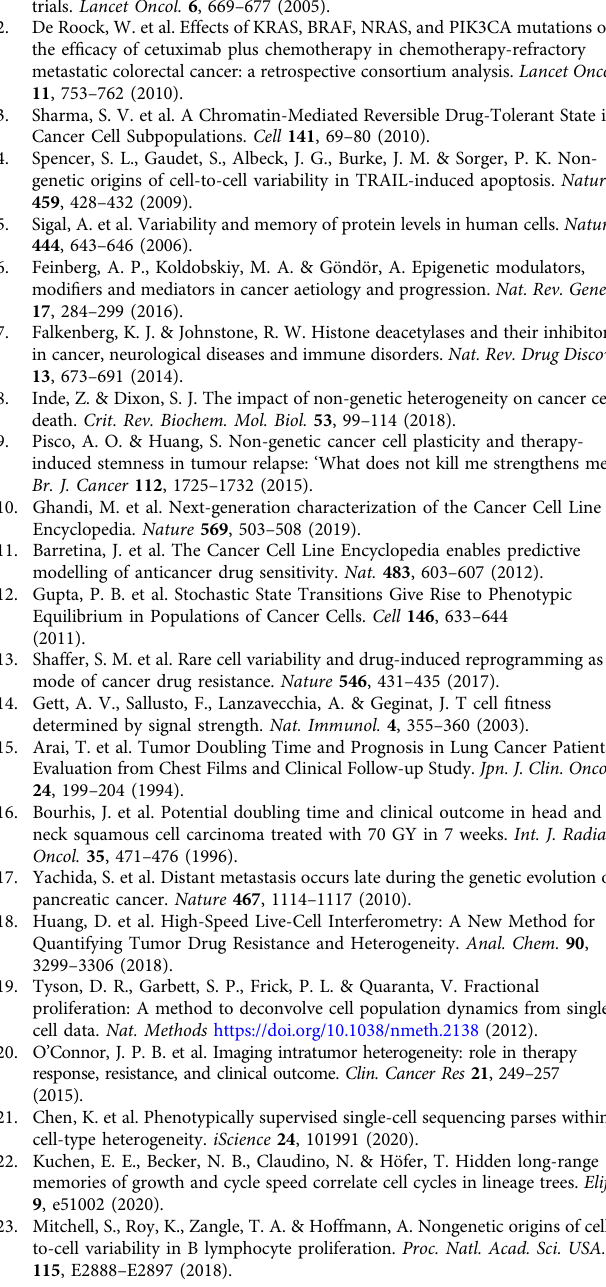
Supplementary Table 2. The transition probabilities were generated by adding 0.1 elementwise to the identity matrix and then normalizing it. The initial probabilities for all states were equal. Fitting was performed with models including 1 – 7 states. The optimum number of states was taken to be the smallest number of states at which the log-likelihood plateaus.